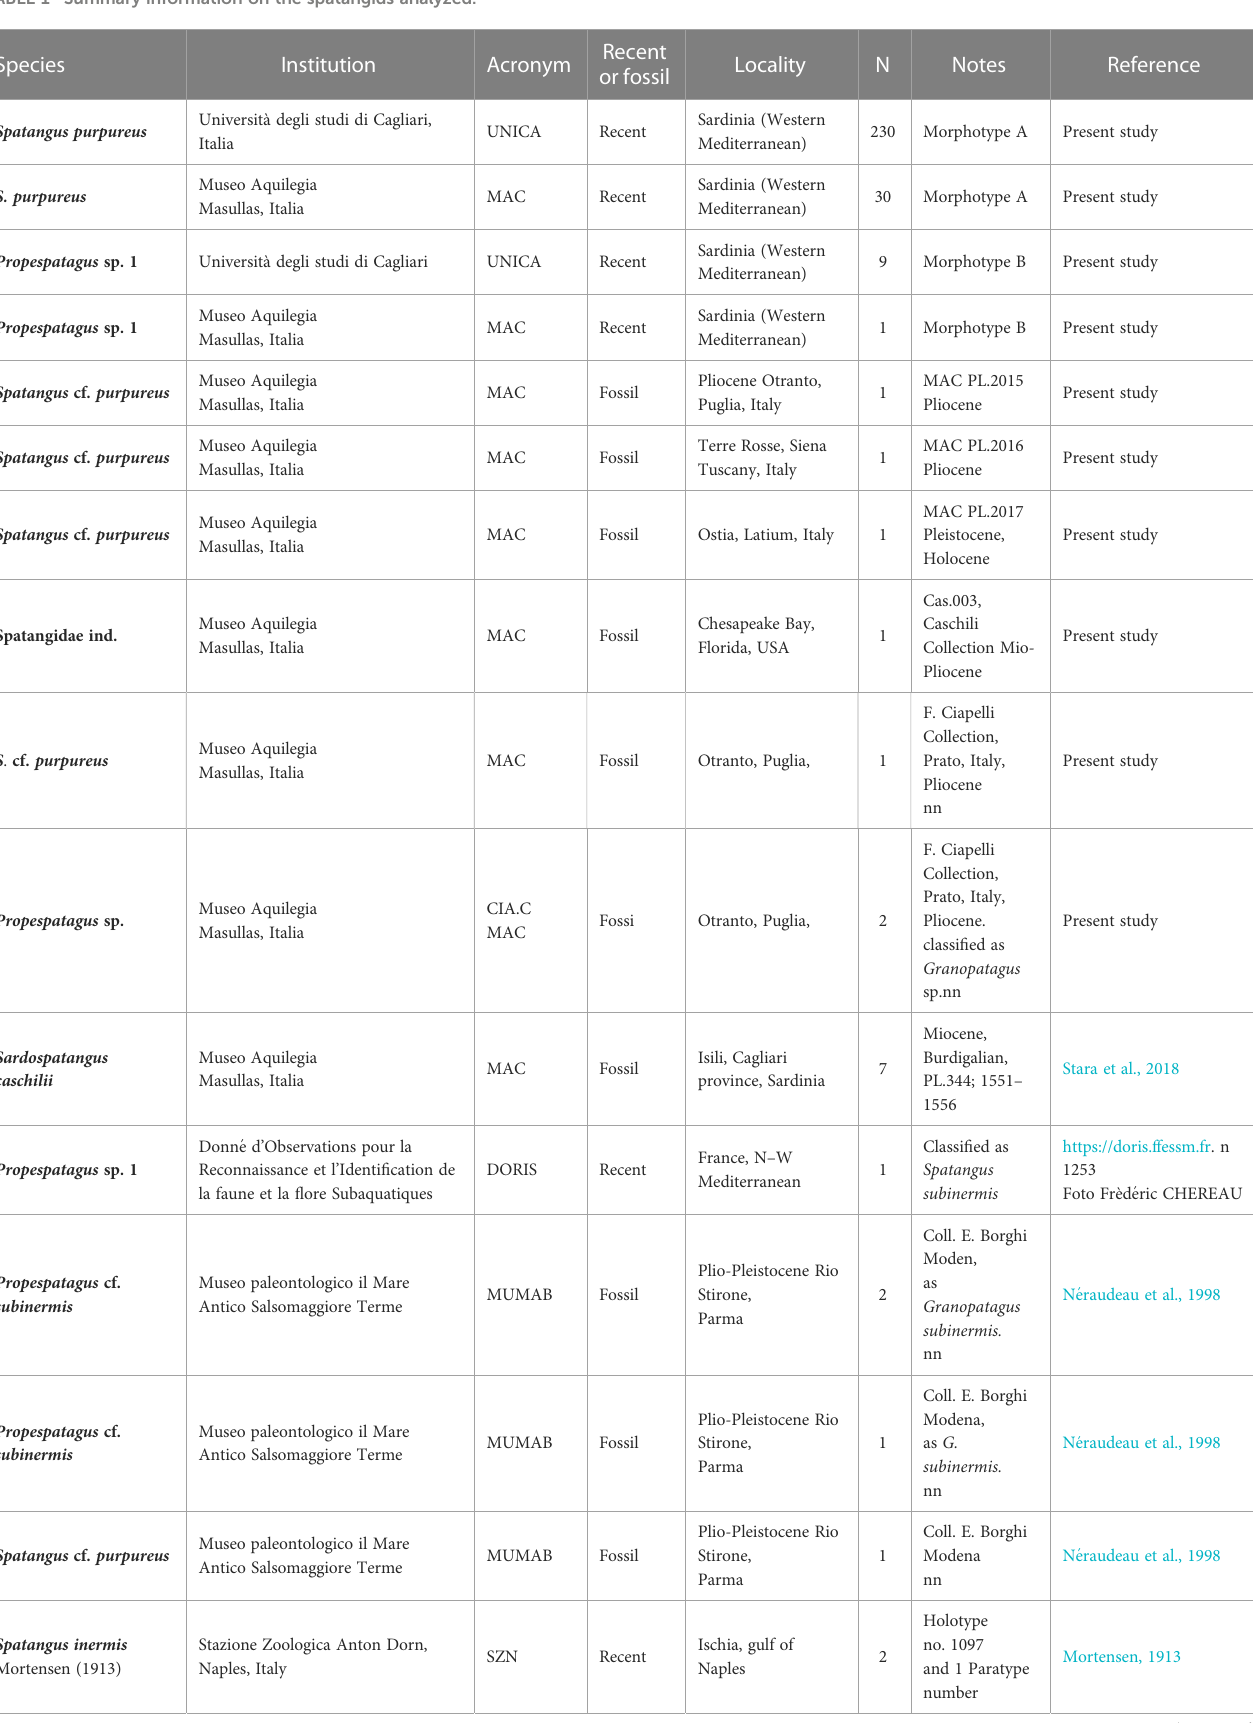
TABLE 1 Summary information on the spatangids